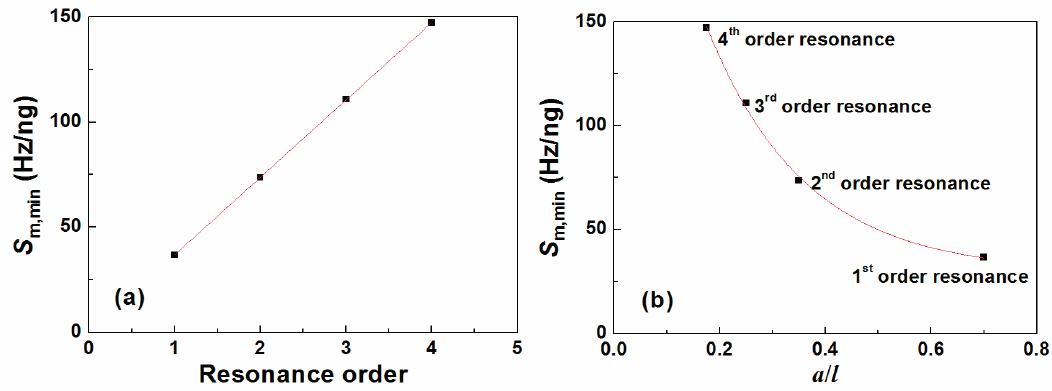
Figure 6. ( a ) The minimum mass sensitivity versus the resonance order where the data is fitted by a linear function; ( b ) The minimum mass sensitivity versus mass load distribution ( a / l ) where the data is fitted by an exponent decaying